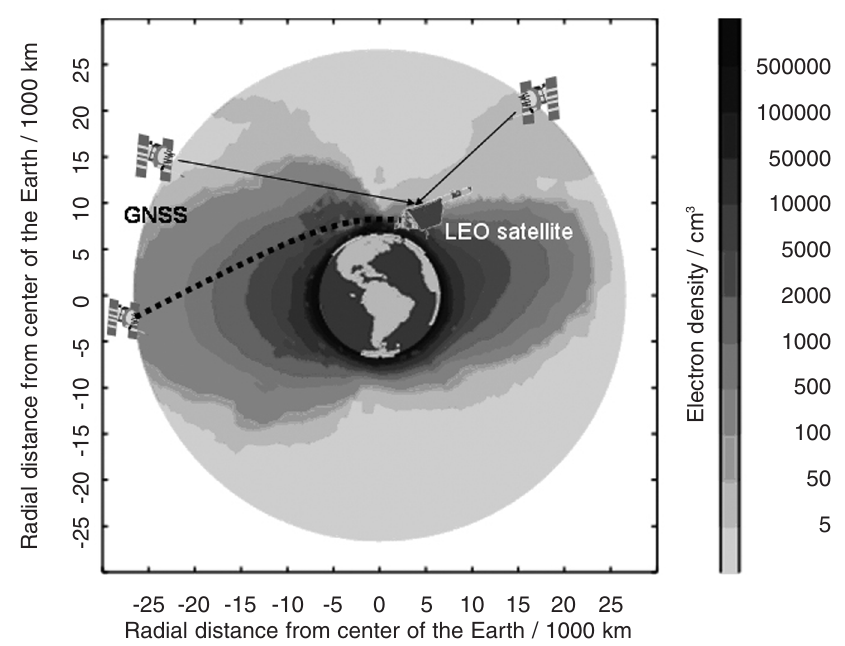
Fig. 7. Sample of topside electron density reconstruction using 0.1 Hz sampled navigation data measured on- board CHAMP. The figure illustrates radio links for radio occultation and topside GNSS